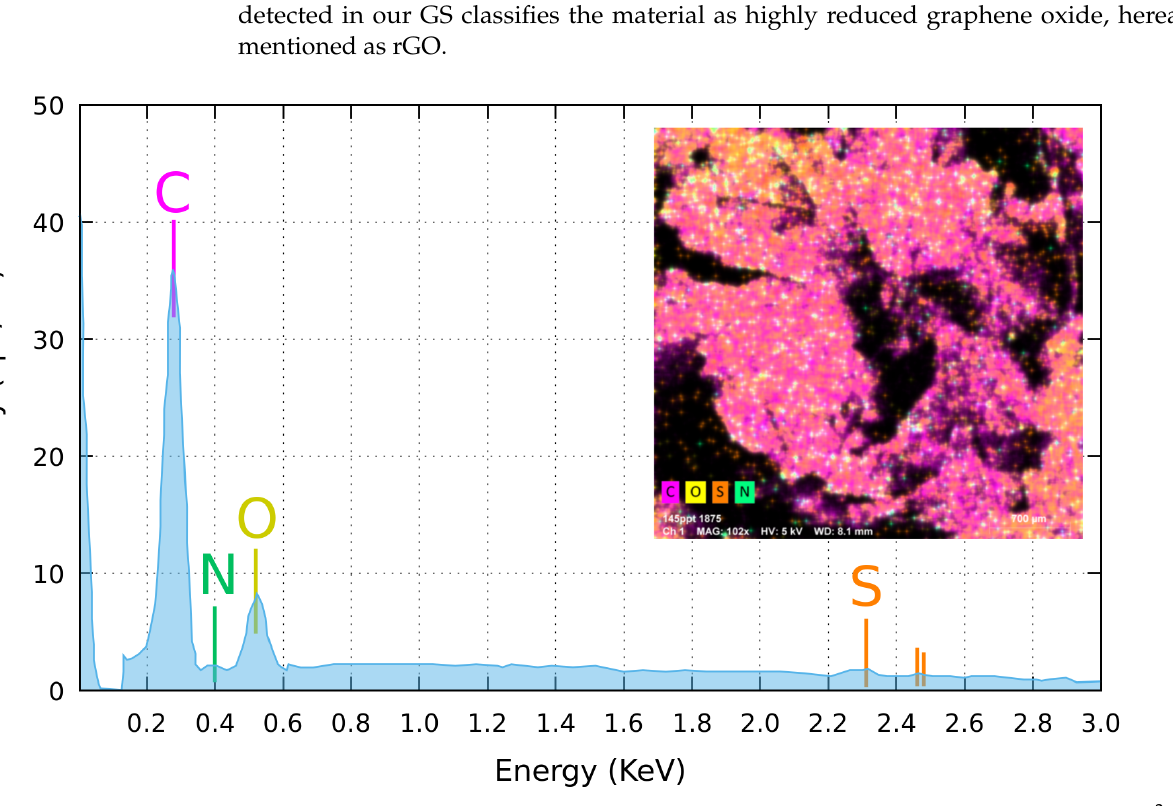
Figure 4. Averaged elemental composition of the GS, carried out by the EDX analysis on a sample surface 3.65 × 3.50 mm 2 large. Inset: elemental composition map of the same area, evidencing a slightly patchy oxygen distribution, here appearing concentrated in the top-left and bottom-right corners of the analysed area. Visible black areas are due to holes in the sponge. Due to the lateral position of the EDX detector with respect to the sample (take-off angle of 35 ◦ , at 8.5 mm above the specimen), signal cannot be collected from the black